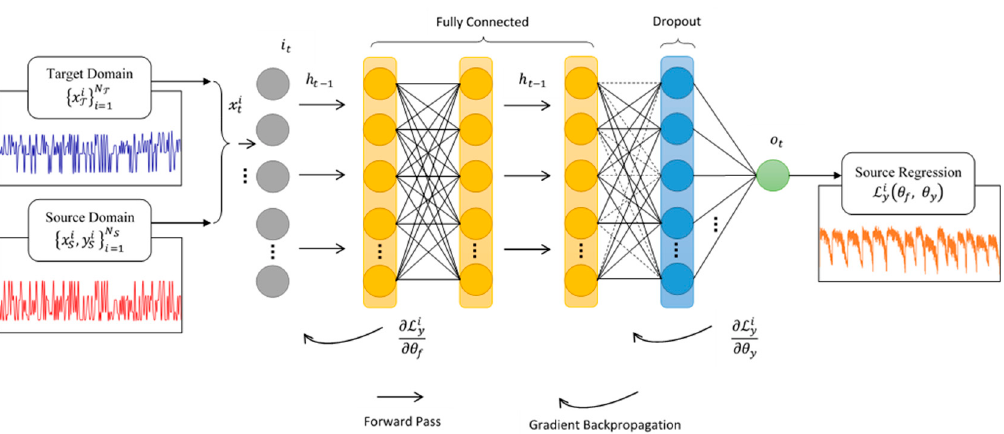
Figure 2. Proposed Deep Neural Networks Model Architecture.